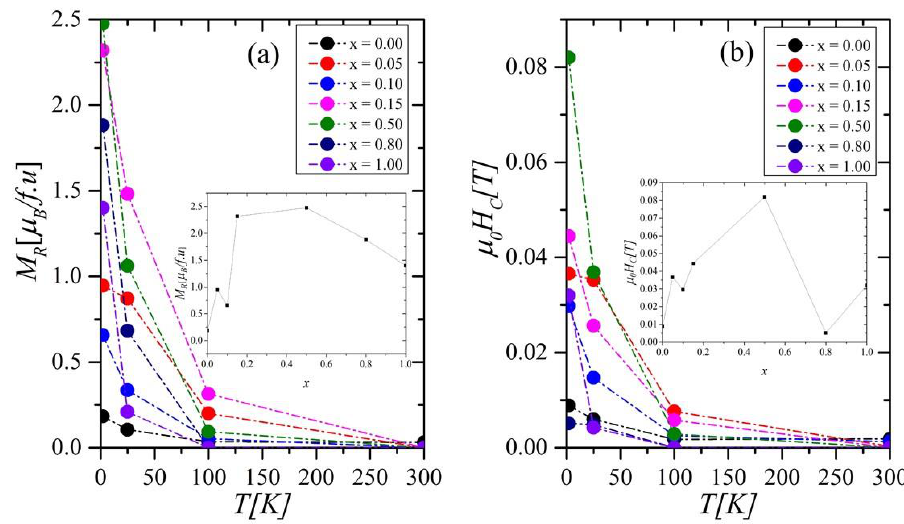
Figure 6. The residual magnetization M R ( a ) and coercive fields H C ( b ) versus T and chemical composition x in the Gd 04 Tb 0.6 (Co 1x Ni x ) 2 compounds. The insets in Figure ( a ) and ( b ) present the concentration dependence of M R and H c , respectively.